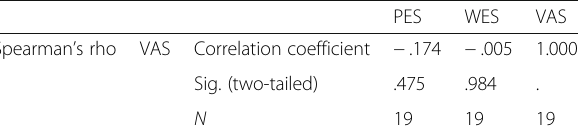
Table 3 Detailed results of pink and white esthetic score analyses